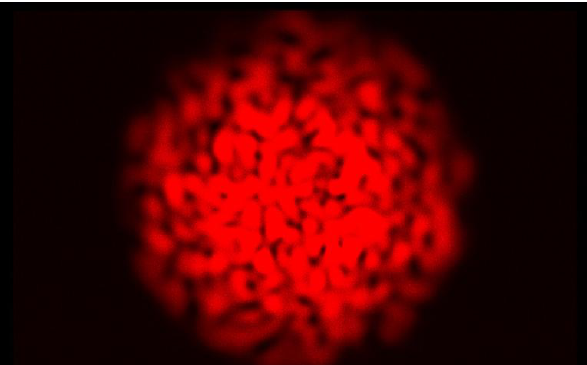
Figure 2. A typical distribution of